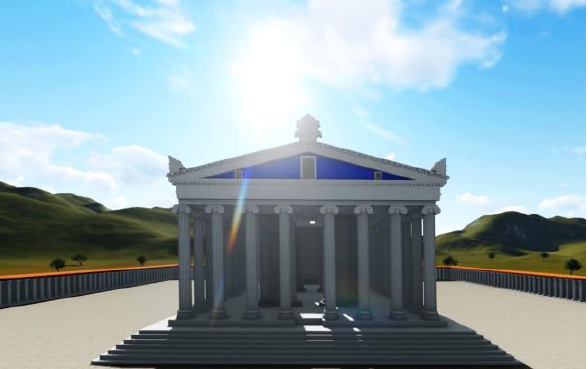
Figure 7. The Reconstruction of the Temple of Artemis Leukophryne at